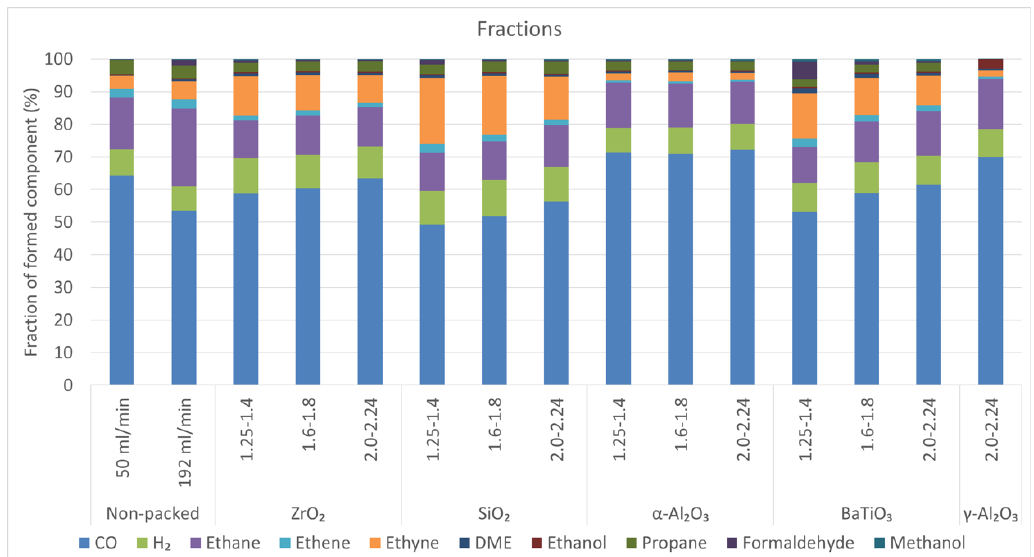
Figure 7. Product fractions for different sphere sizes and materials, as well as for the non-packed reactor.